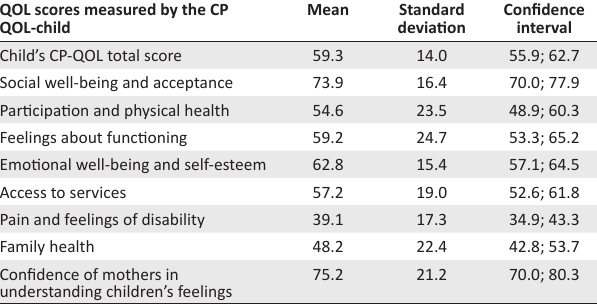
TABLE 2: Results of the cerebral palsy quality of life-child calculated in children with cerebral palsy. QOL scores measured by the CP QOL-child